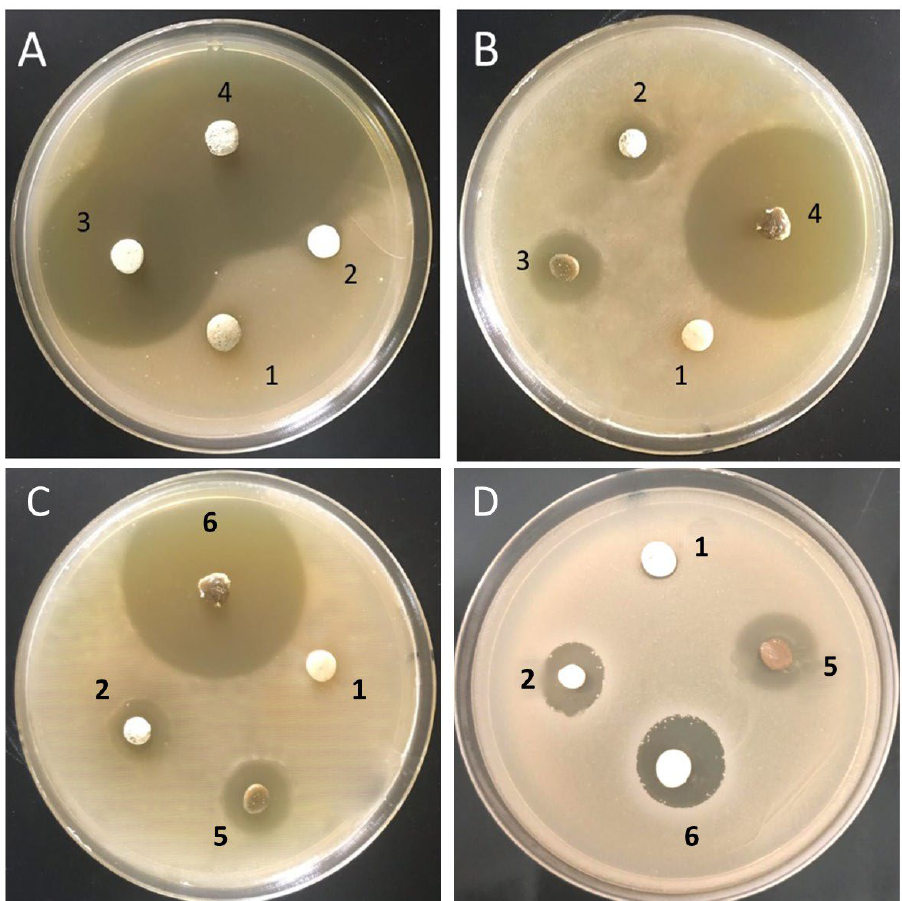
Figure 7. Antimicrobial activity of the biomaterials against Staphylococcus aureus ( A , C ) and Streptococ- cus mutans ( B , D ). 1—(Group 1) GIC; 2—(Group 2) 98.5% GIC with 1.5% metronidazole; 3—(Group 3)